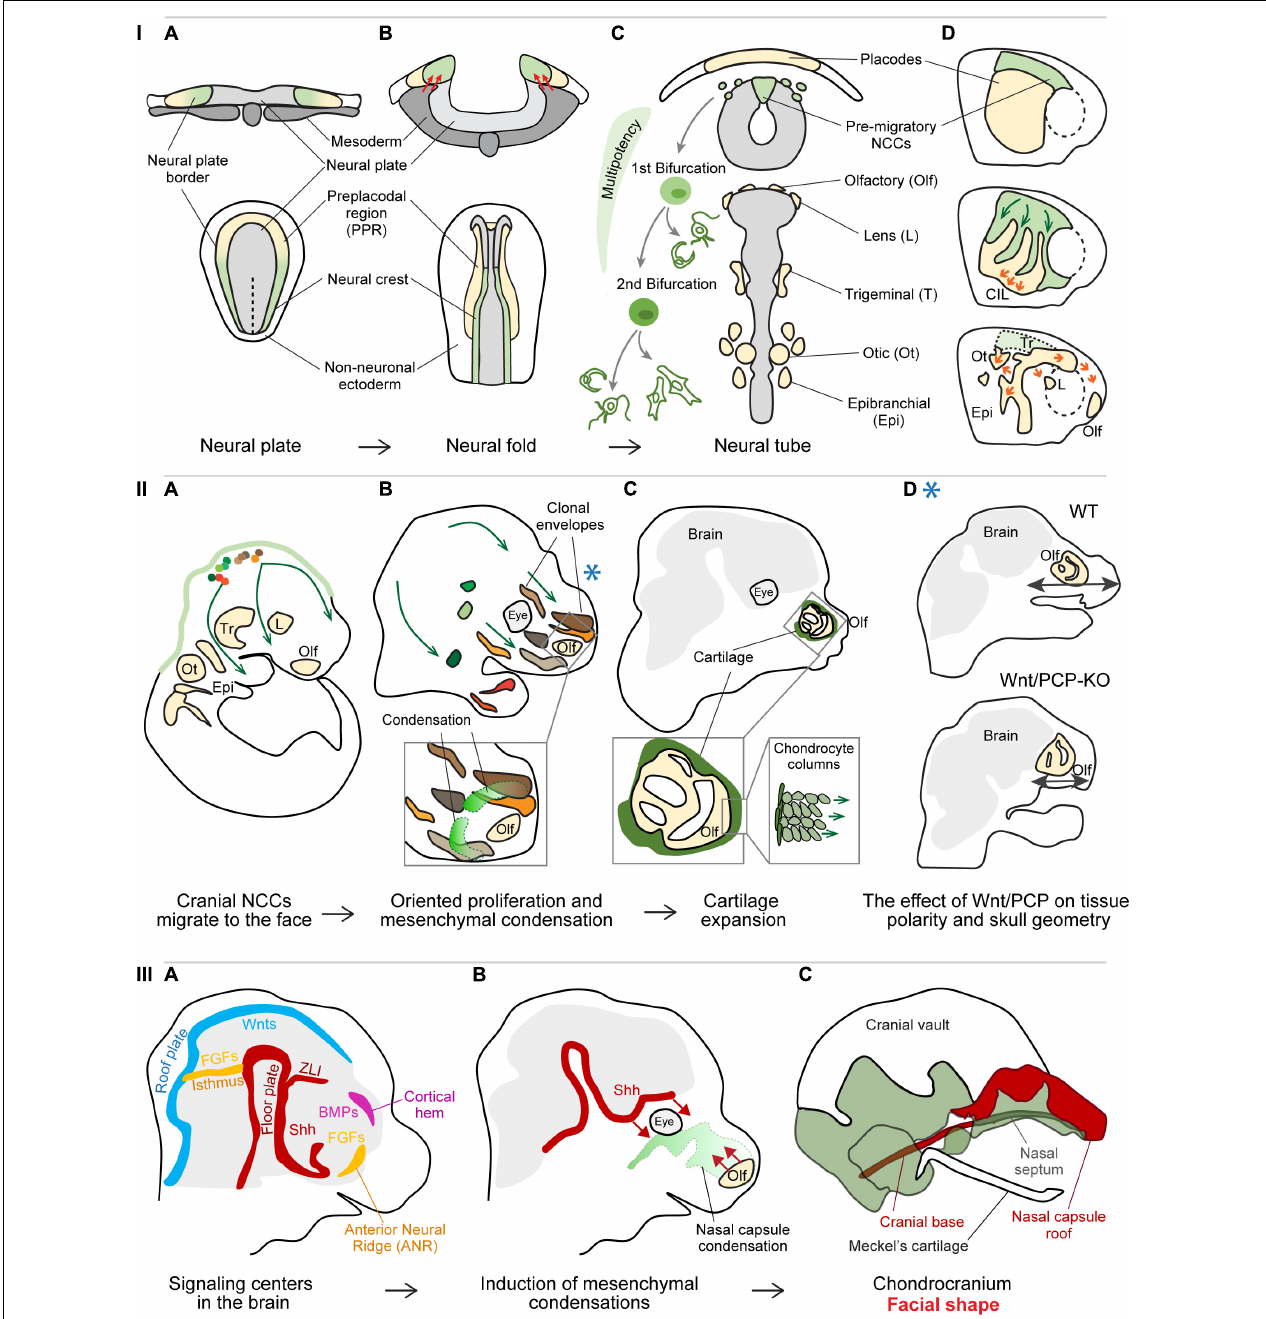
FIGURE 1 | Panel I: Specification and cell fate acquisition of the neural crest cells (NCCs). (A) NCCs and placode progenitor cells are localized adjacent to each other at the neural plate border. (B) When neural folds are brought together, the stiffened mesoderm underlying the cranial NCCs (red arrows) triggers NCC EMT and initiate NCC migration. (C) The migrating NCCs undergo a gradual process of cell fate acquisition, during which the NCCs pass through two main bifurcation points. The first separation leads to the split of sensory and autonomic/mesenchymal fates, and the second separation leads to the emergence of autonomic and mesenchymal fates. Placode progenitors are split from the common PPR into individual placodes to give rise to different sensory organs or cranial ganglia. (D) NCCs migration streams and placode separation are a result of the interaction between NCCs and placode cells (middle): NCCs are attracted by placode cells (green arrows), after their direct contact placode cells are repolarized and move away from the NCCs (orange arrows), in a process called contact inhibition locomotion (CIL). Due to their active directed cell migration (orange arrows, below), the individual placode territories are established and NCCs had along their stereotypical migratory pathways. (A–C) Upper row transversal view, lower row: dorsal view; (D) lateral view. Panel II: Cellular behavior during early craniofacial morphogenesis. (A) The cranial NCCs migrated into their respective destinations and proliferate generating facial ectomesenchyme. (B) The progeny of each cranial NCC occupies